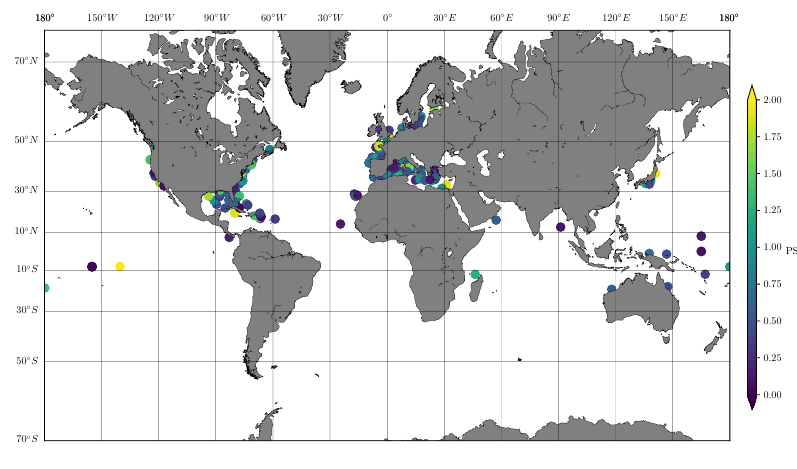
Figure 6. Salinity interpolation. Training : predicted vs. in situ data ( top left ); histogram of residuals in training ( top right ). Test : predicted vs. in situ data ( centre left ); histogram of residuals ( centre right ); difference between measured and predicted salinity in test locations ( bottom ). Units of salinity are PSU.